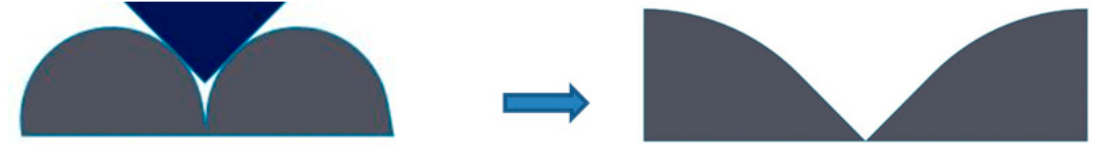
Figure 4. Schematic of the printed layers with the roughness tip, for print orientation angles higher than 45°.